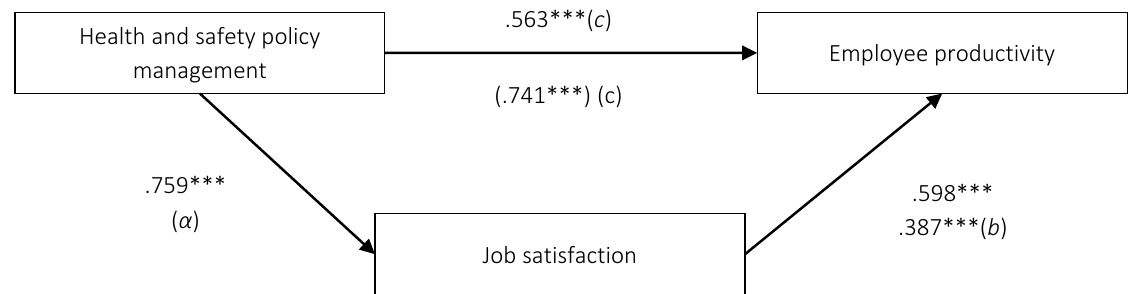
Figure 1. Standardized coefficients of the mediating